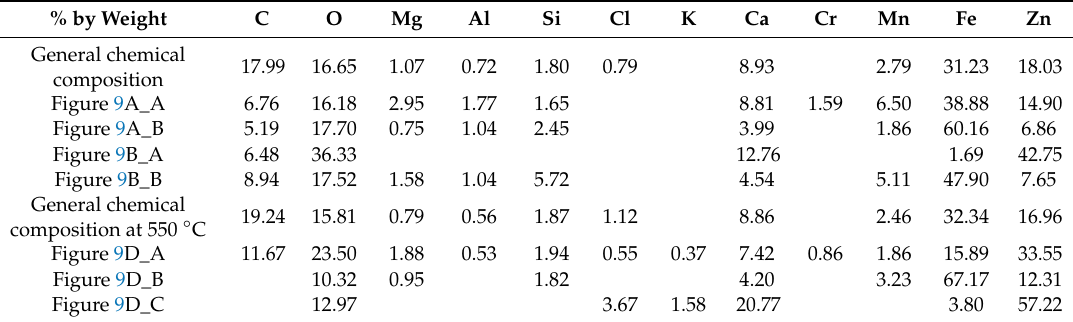
Table 10. SEM-EDS analysis of as-received and thermal-treated fine combustion chamber residues. % by